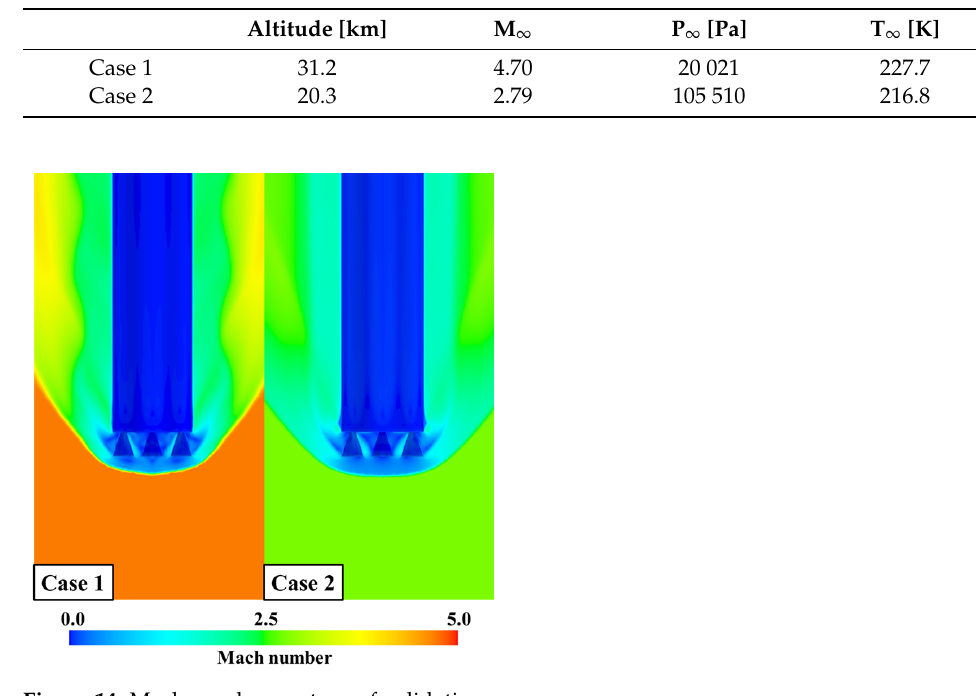
Figure 13. Mesh of validation case. Table 8. Boundary conditions for validation [16].